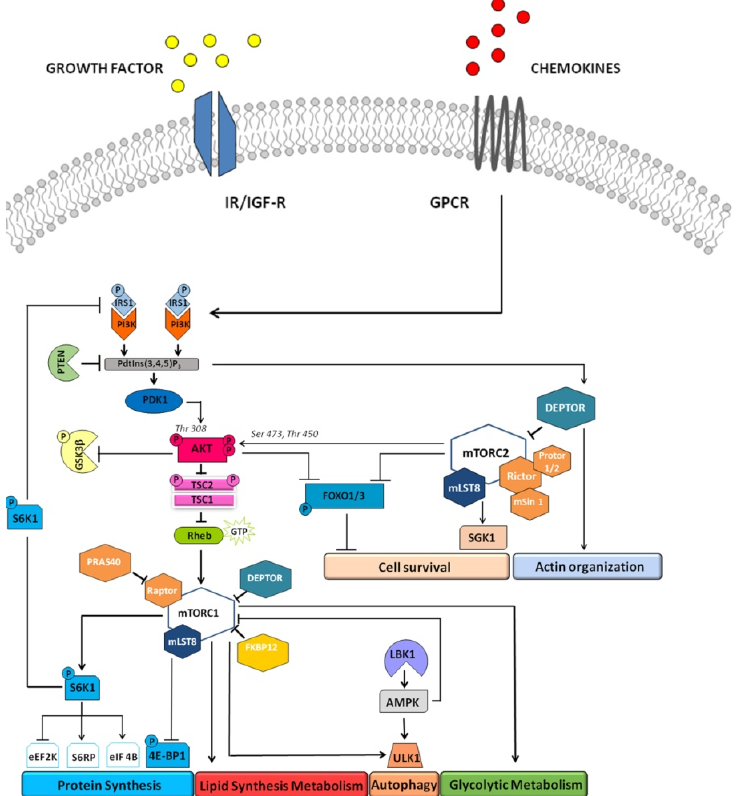
Figure 3. mTOR signaling network. The serine/threonine kinase mTOR is found in two multiprotein complexes: mTORC1 is composed of RAPTOR, PRAS40, mLST8, and DEPTOR, which has an inhibitory function on mTORC1. The mTORC1 is activated by growth factors, chemokines, nutrients (glucose, amino acids), and the cell energy status (i.e., a high ATP/AMP ratio). mTORC1 stimulation is activated by growth factors through the phosphoinositide 3-kinase (PI3K)-AKT signaling pathway. AKT phosphorylates tuberous sclerosis complex 2 (TSC2 or hamartin) at multiple sites. TSC2 is a GTPase-activating protein (GAP) that associates with tuberous sclerosis 1 (TSC1 or tuberin) for inactivating the small G protein Rheb (Ras homolog enriched in brain). Once AKT phosphorylates TSC2, the GAP activity of the TSC1/TSC2 complex is repressed, allowing Rheb to accumulate in a GTP-bound state. Therefore, Rheb-GTP upregulates mTORC1 protein kinase activity. AKT also phosphorylates PRAS40 (at Thr246), which dissociates from mTORC1 in response to growth factors, or glucose and nutrients, thereby releasing the inhibitory function of PRAS40 on mTORC1. mTORC1 activates S6K1 through phosphorylation, and S6K1 in turn phosphorylates or binds proteins such as eukaryotic elongation factor 2 kinase (eEF2K), which targets eEF2 and regulates the elongation step of protein translation, ribosomal protein S6 (S6RP), and eukaryotic initiation factor 4B (eIF4B), ultimately promoting translation initiation and elongation. mTORC1 also phosphorylayes and inactivates the translation inhibitor 4E-BP1, which has a role in inhibiting cap-dependent translation through the binding of the translation initiation factor eIF4E. mTORC1 is a repressor of autophagy, through phosphorylation of Unc-51 like autophagy activating kinase 1 (ULK1), and positively controls lipid synthesis and glycolytic